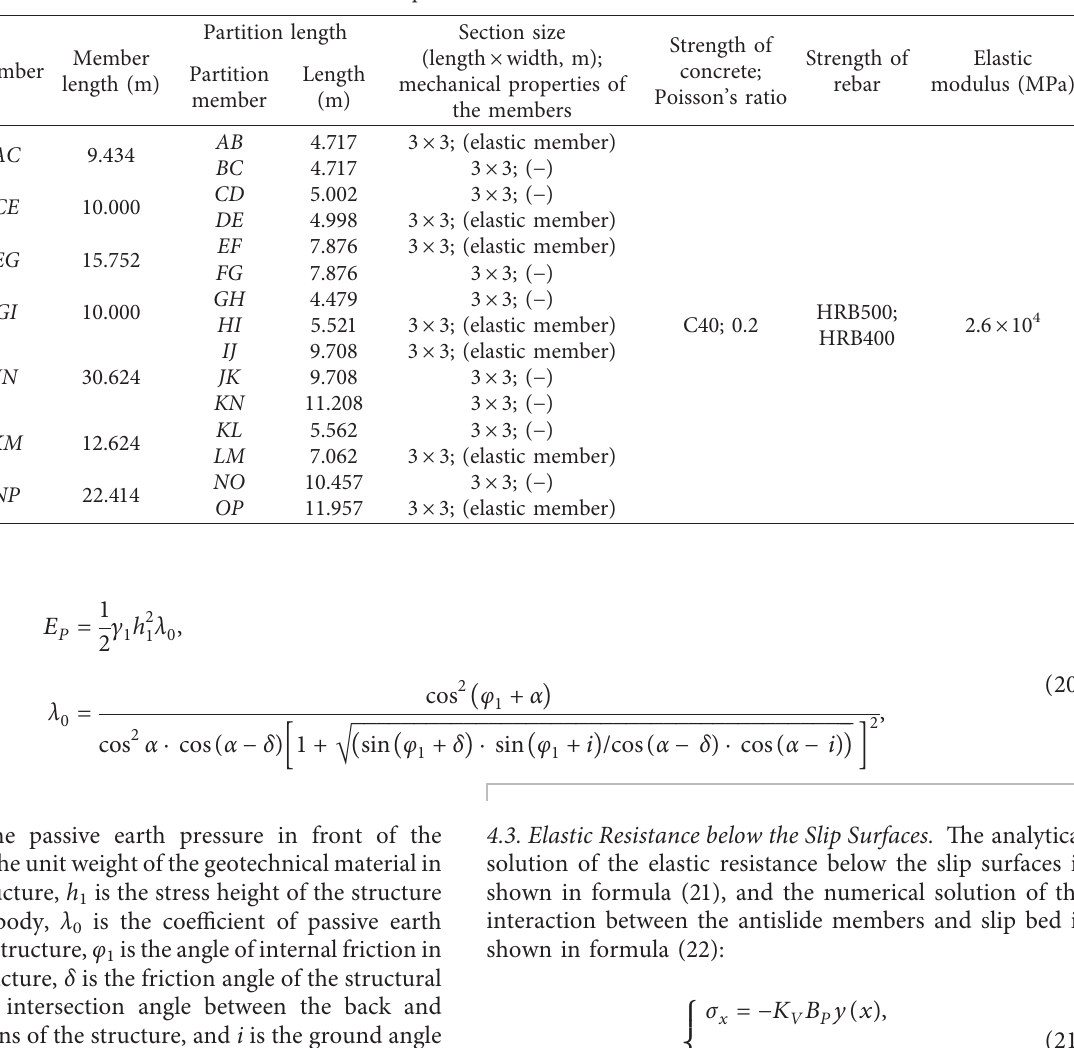
Table 2: The mechanical parameters of the antislide